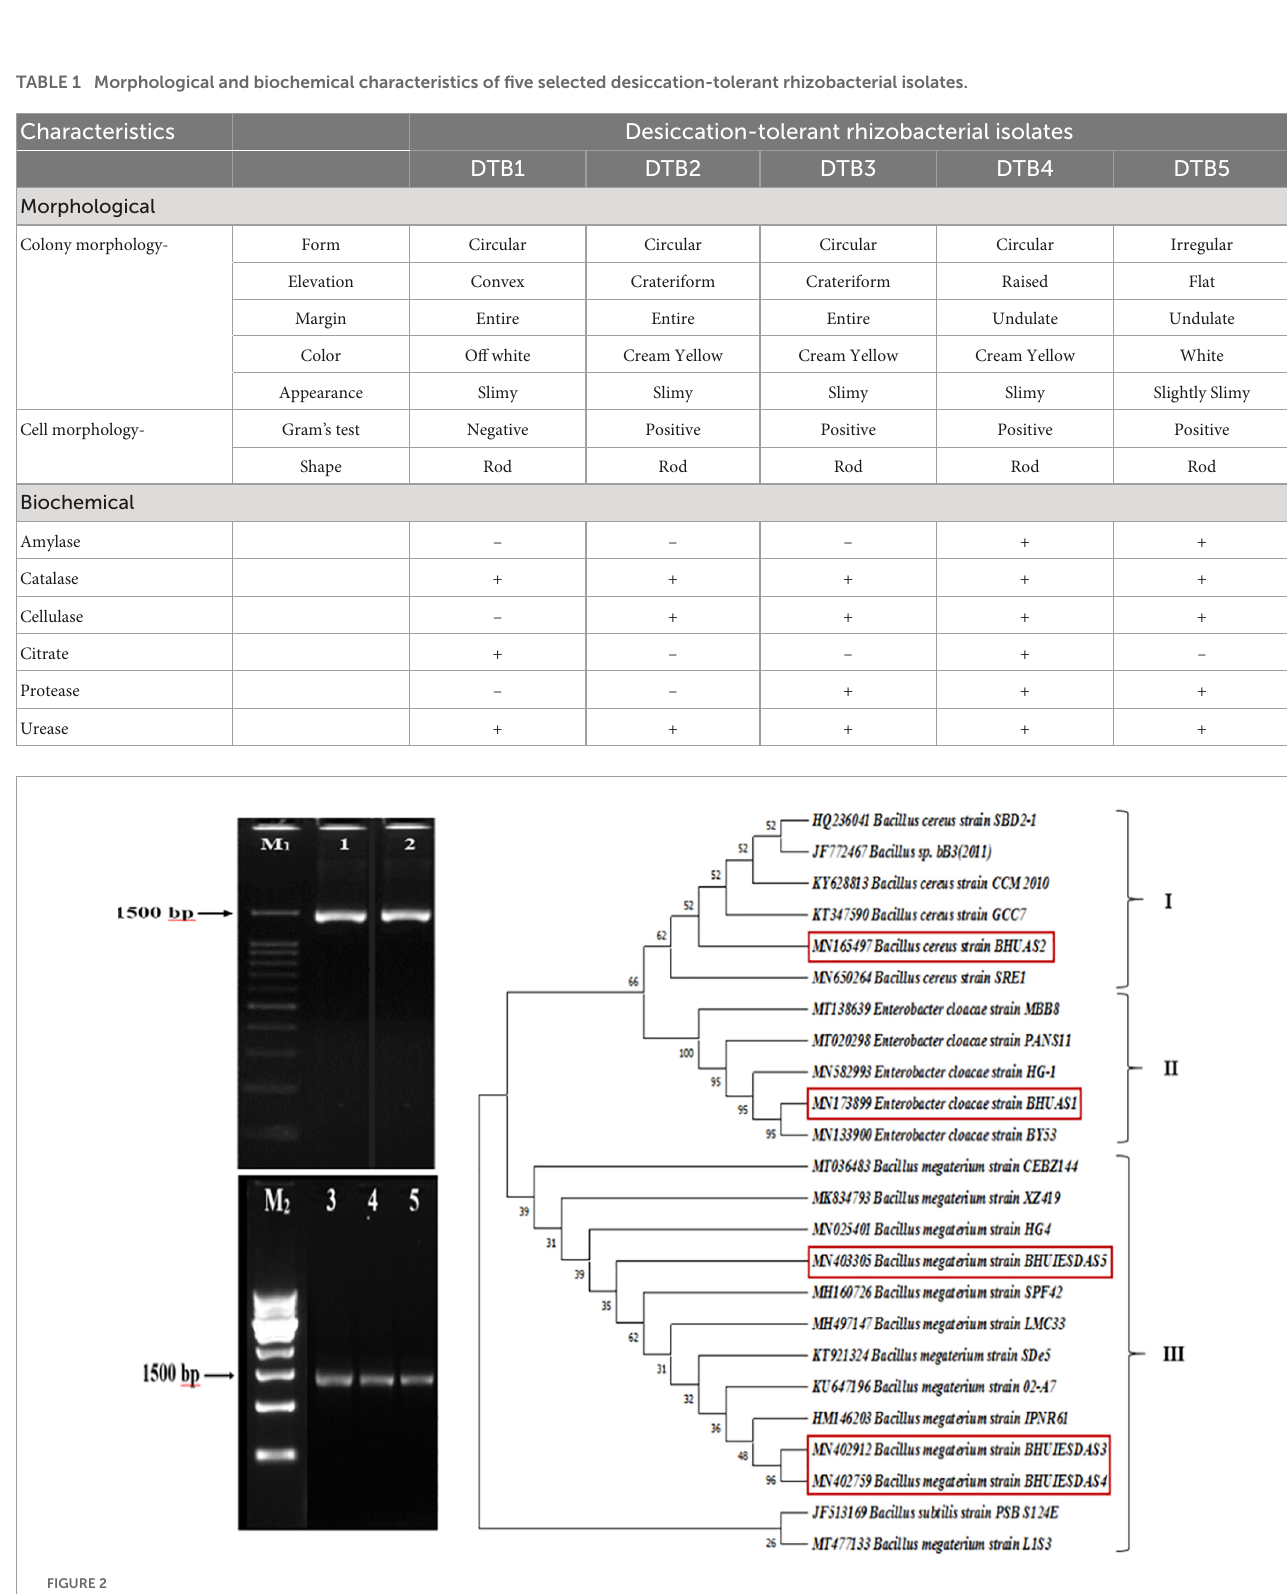
FIGURE2 Gel-electrophoresis image showing the 1,500 bp amplified product of 16S rDNA gene from the five selected desiccation-tolerant rhizobacterial isolates 1-DTB1, 2-DTB5, 3-DTB2, 4-DTB3, and 5-DTB4. M1 is a 100 bp ladder and M2 is a 500 bp ladder. Phylogenetic tree obtained by the UPGMA method and bootstrap clustering showing the similarity relatedness of the selected rhizobacterial isolates and their relative position in respective